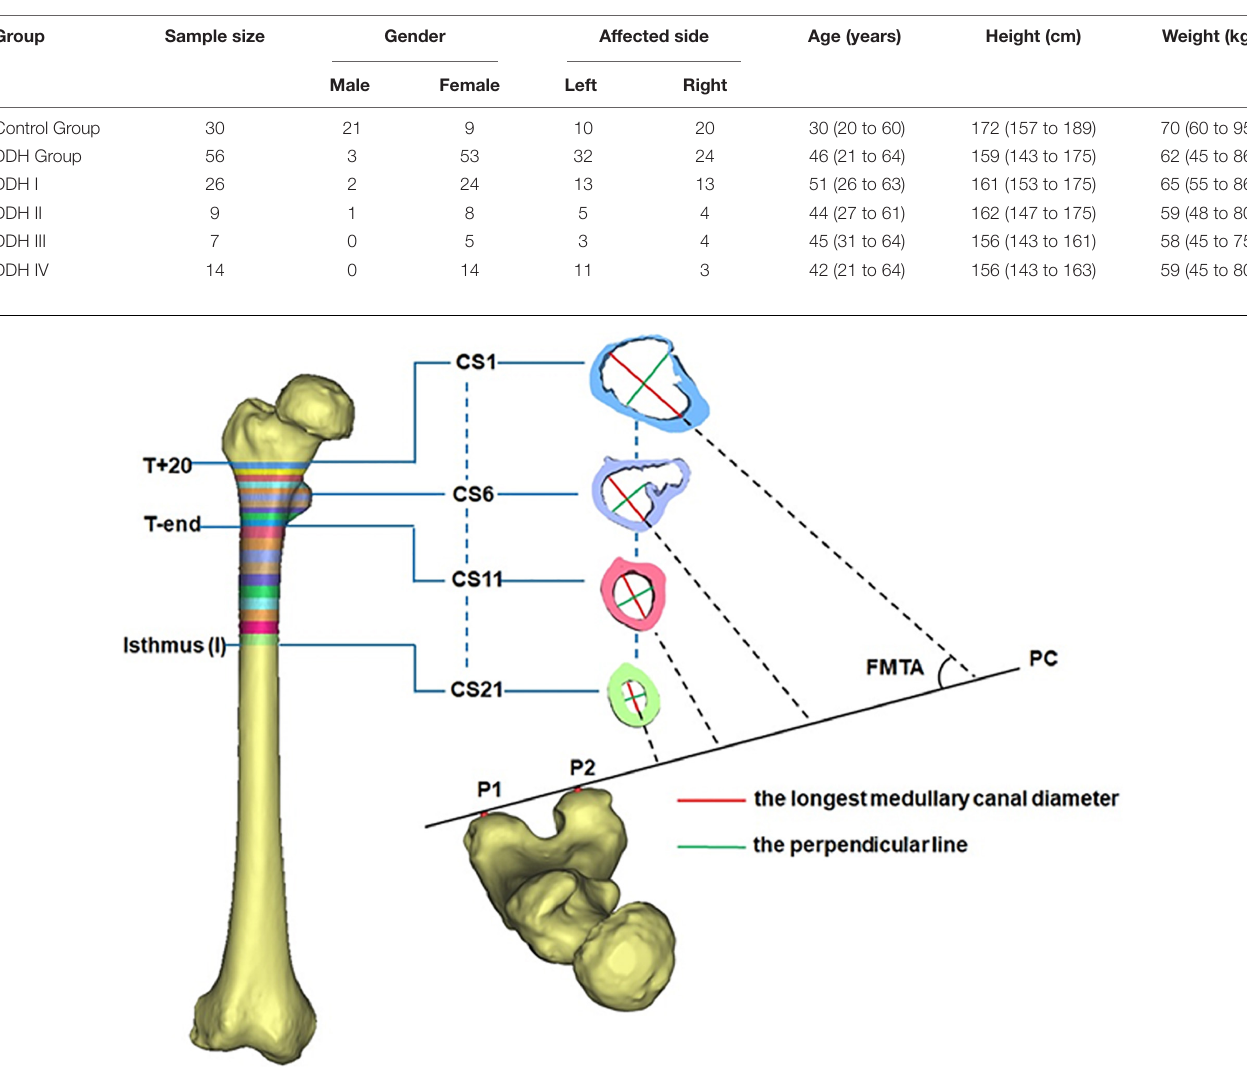
The variation in the longest canal diameter from T + 20 to T-end and from T-end to isthmus were, respectively, calculated for each femur to investigate the change in the size of the femoral cavity.